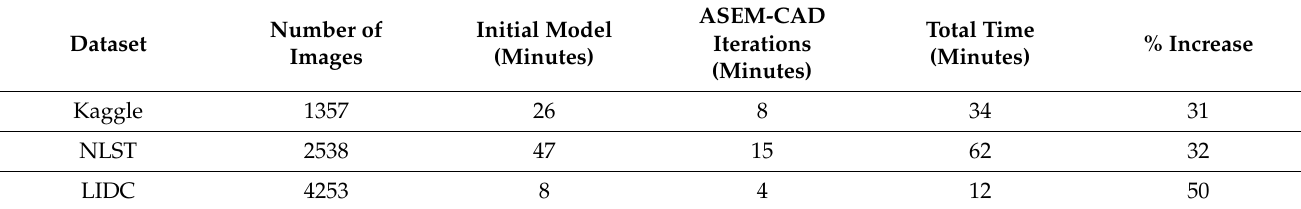
Table 3. Training time for the ASEM-CAD algorithm estimated based on 10 EM